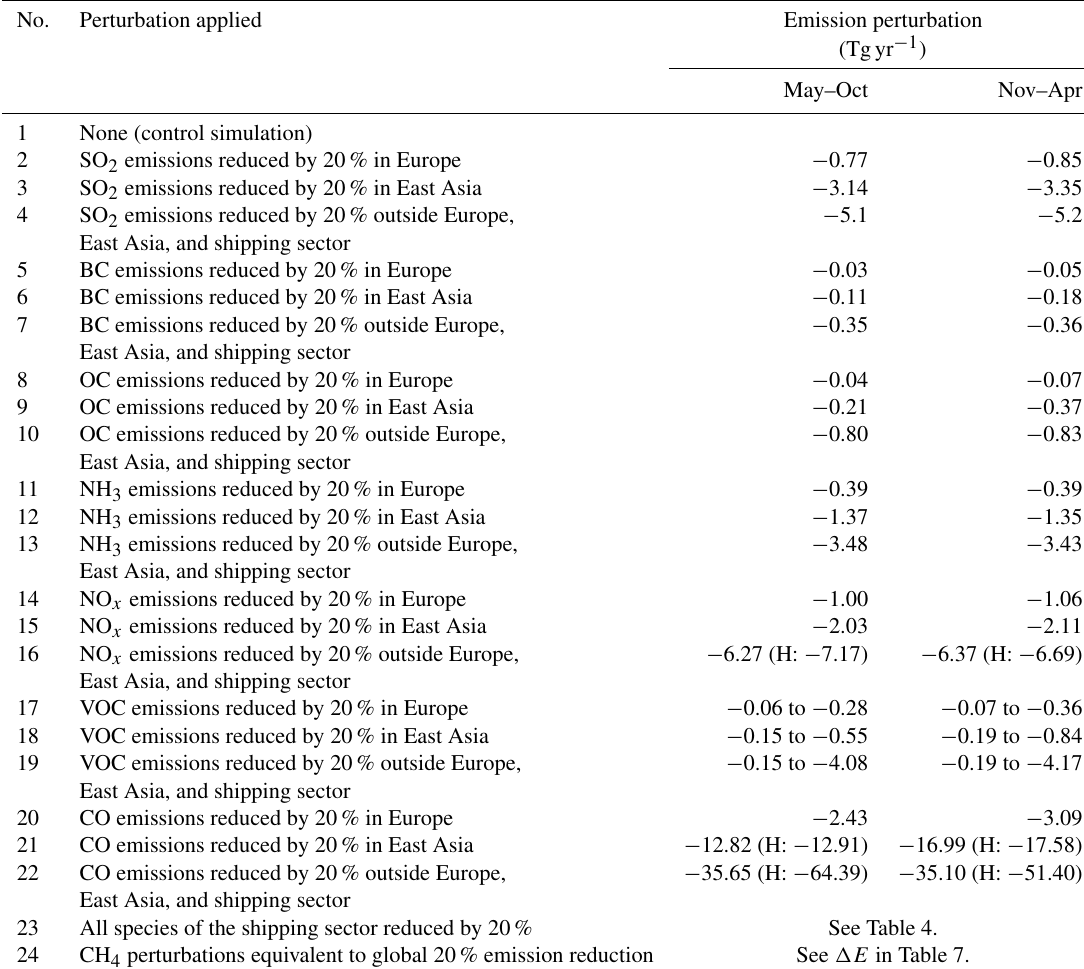
Table 3. List of simulations made to provide radiative forcing by regional and seasonal perturbations and size of the emission perturbation applied to the anthropogenic component for the year 2008, in Tgyr − 1 . For some ozone precursors, HadGEM3 also perturbed the biomass- burning component, so the size of its perturbation is given in parentheses (H:) for species and regions with strong biomass-burning sources. Emitted masses are in [C] for black and organic carbon and volatile organic compounds. They are in [NO 2 ] for NO x .